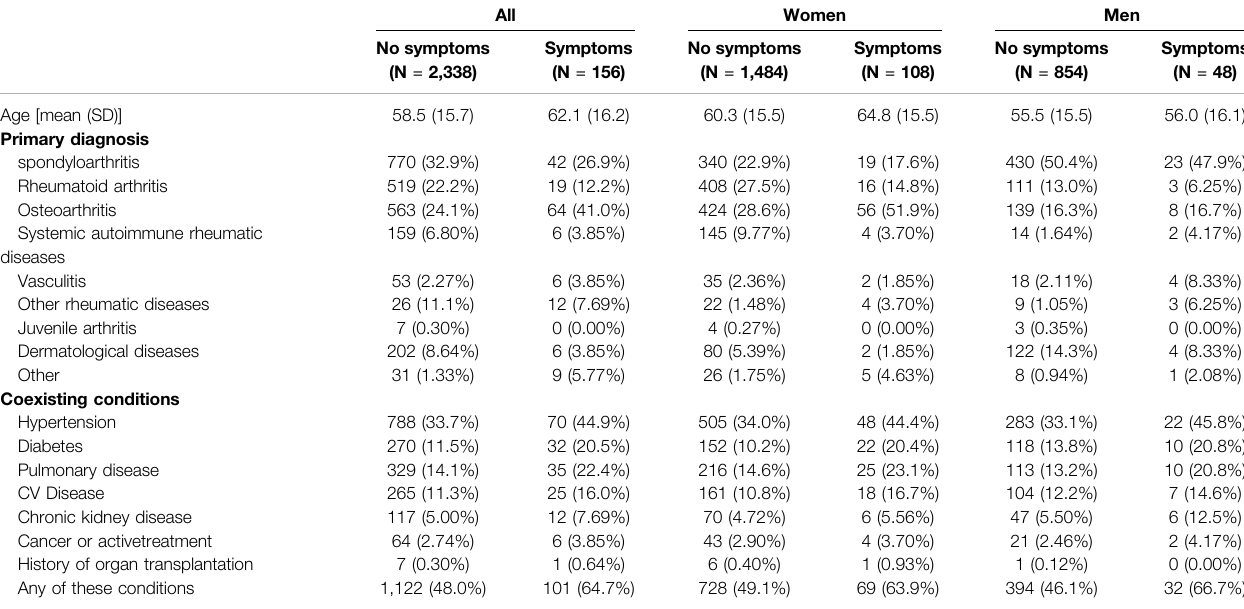
TABLE 3 | Distribution of COVID-19 across categories of study variables.